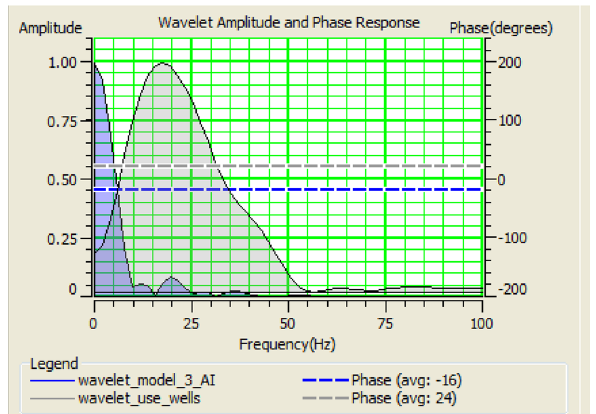
Fig. 3 Comparison of amplitude spectrum of wavelet extracted from the seismic data (light blue shade) and that extracted from the low- frequency model built from well logs(dark blue shade) for model- based inversion process to compensate for depleted low-frequency spectrum of the seismic data